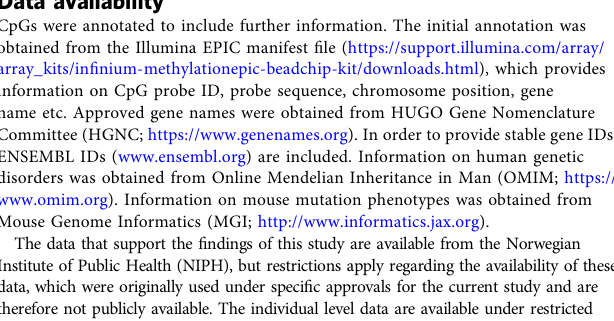
Fig. 8 Quantile-Quantile plots of observed versus predicted − log 10 P values for methylation differences with ART in CpGs associated with birthweight and neurodevelopment. The observed − log 10 P values on the y-axis (calculated from t statistics) were derived from two-sided t tests for: ( a ) the association between DNA methylation levels and birthweight on a continuous scale (in grams) and ( b ) the difference in DNA methylation levels between subjects with Mendelian neurodevelopmental disorders and controls. Blue dots indicate the P values for a subset of CpGs that have been reported to be signi fi cant for birthweight and neurodevelopmental disorders. For comparison, the P values for the overall associations of ART compared to naturally conceived are shown in gray. The diagonal lines indicate expected P values if there were no difference between the groups. Source data are provided as a Source Data fi